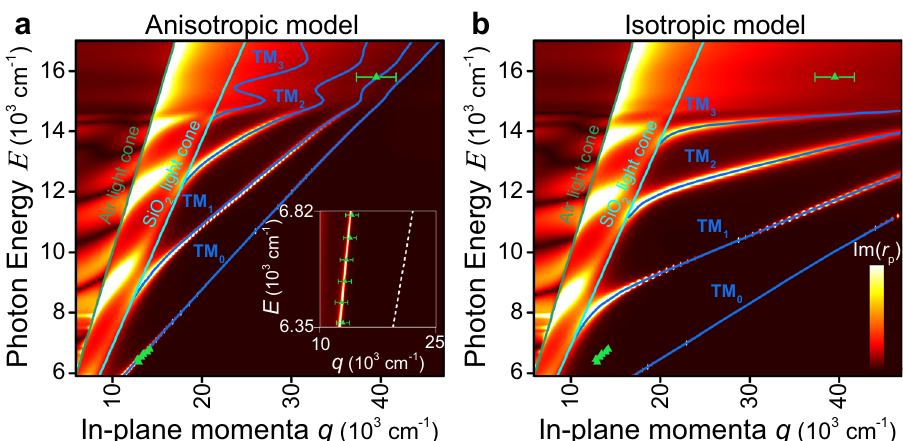
Fig. 4 Dispersion of a planar MoS 2 waveguide. a , b Transfer matrix calculations 49 for the MoS 2 /SiO 2 /Si system for MoS 2 anisotropic and isotropic (in the assumption of optical constants for the c-axis equal to those for the ab-plane) models. The experimental ( q = 1/ λ , E = h ∙ c / λ ) data points (green triangles) show good agreement with the calculated dispersion (blue lines) based on the anisotropic dielectric function from Fig. 2a. The inset is a magni fi ed near- infrared spectral range with a white dashed line illustrating the isotropic case ’ s dispersion relation. The error bars show the uncertainty in the determination of mode in-plane momenta q from near- fi eld images displayed in Fig. 3.